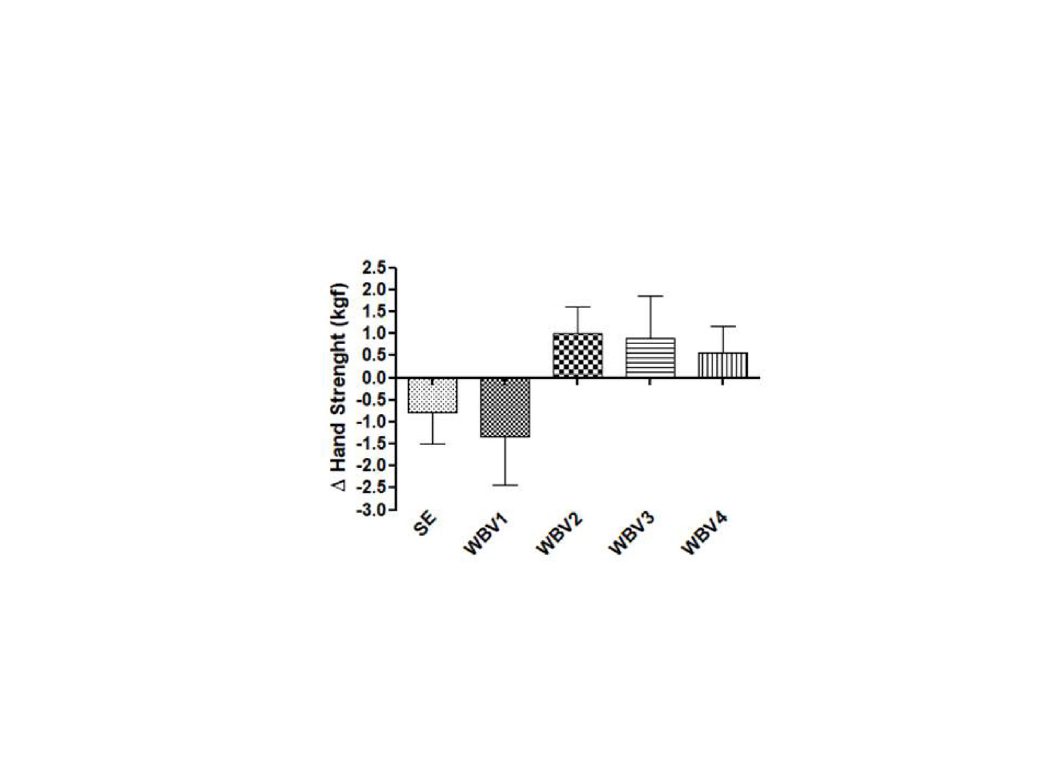
Figure 3 - The change (Δ = Post – Pretest) in handgrip strength among the experimental conditions